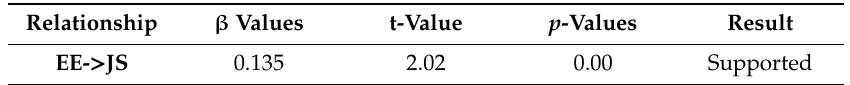
Table 5. Results of moderation Analysis of Perceived Organizational Support on Extent of Exposure (EE)–Job Stress (JS).